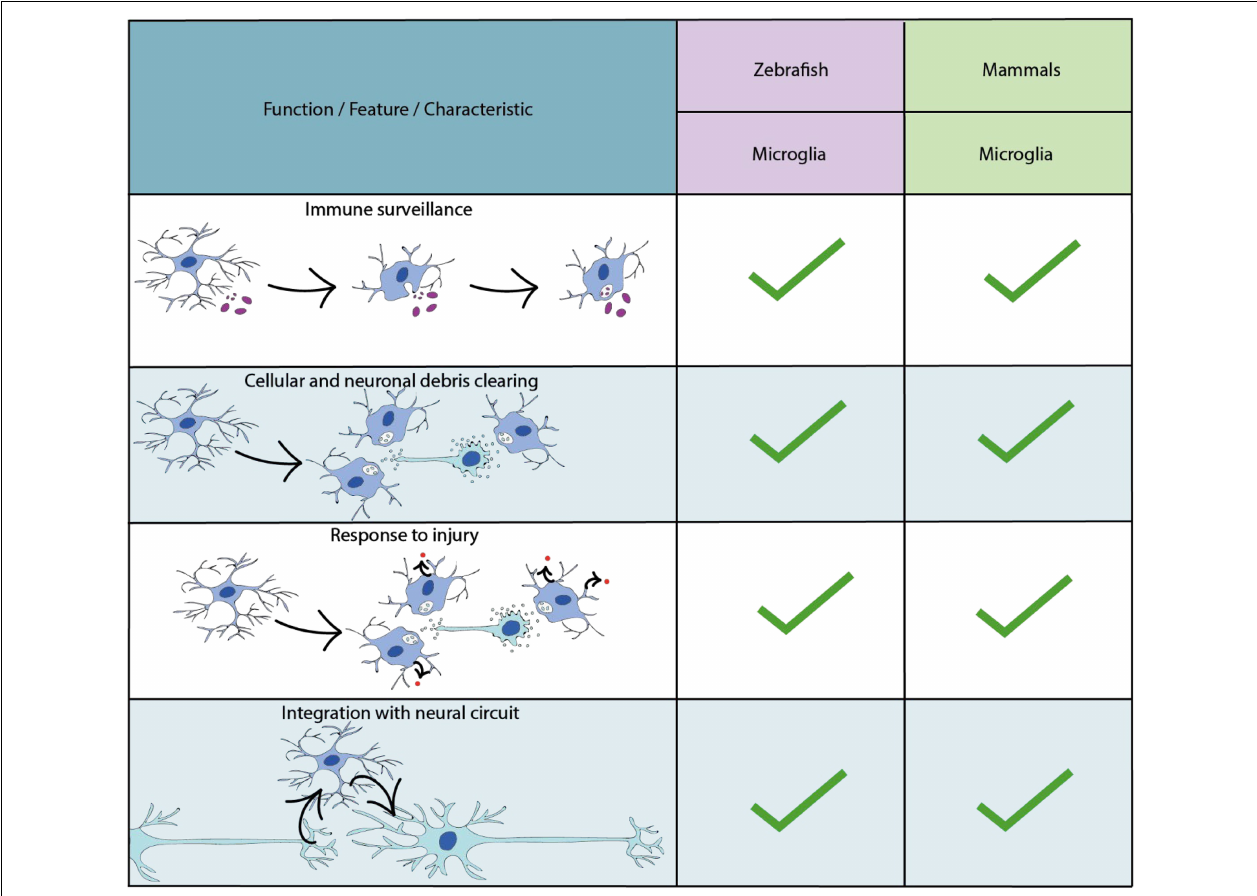
FIGURE 4 | Key characteristics and functional properties of zebrafish and mammalian microglia. The use of “ ... ” refers to areas of microglial biology which require further